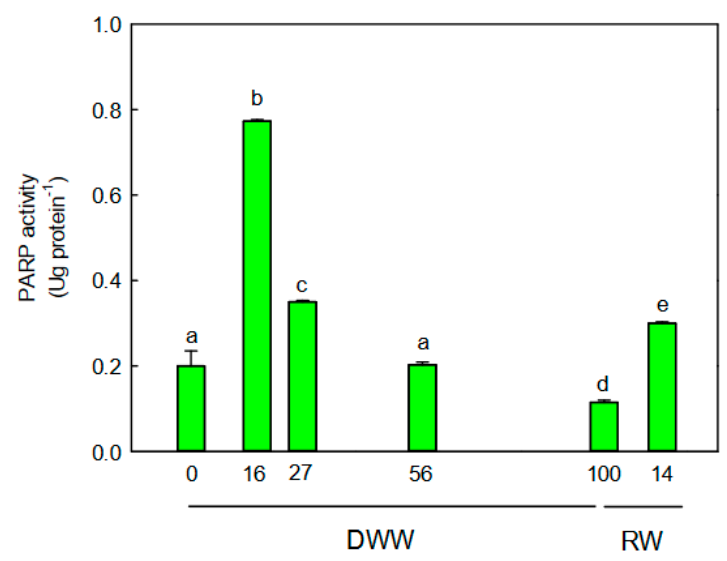
Figure 5. Trends of Poly (ADP-Ribose) Polymerase (PARP) activity during days without water (DWW), and rewatering (RW). Different letters indicate statistically significant differences ( p ≤ 0.05) among different days. Data were analyzed by one-way ANOVA repeated measurements followed by Tukey’s test. Data are means ( n = 10) ± SE.